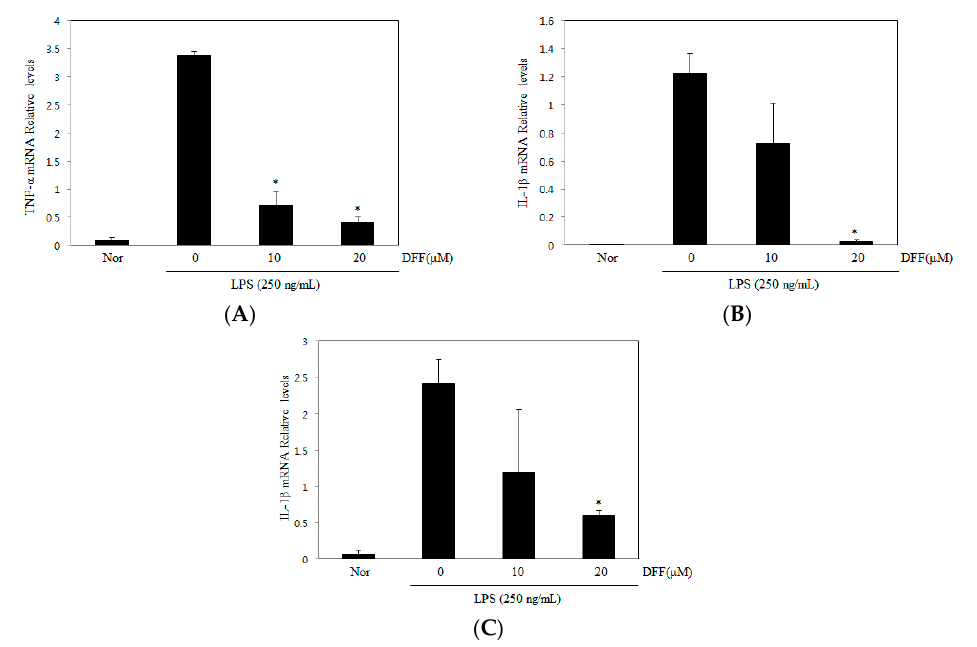
Figure 7. Effect of DDF on macrophage cytokines. LPS-stimulated macrophages were cultured in the presence or absence of DDF. Cytokine levels of ( A ) tumor necrosis factor- α (TNF- α ); ( B ) interleukin-1 β (IL-1 β ); and ( C ) interleukin-6 (IL-6) were measured by qRT-PCR. Nor, untreated control cells; LPS, treatment with only LPS (250 ng/mL). Data represent the mean ± SEM of three experiments. * Significant difference from LPS cells, p < 0.05.